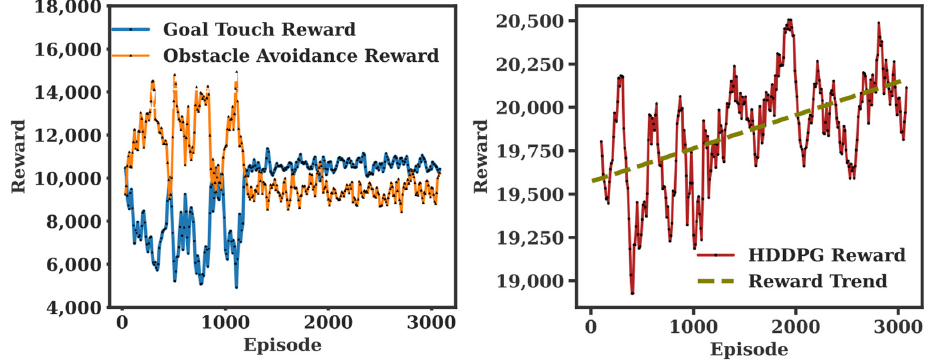
Figure 7. HDDPG training results.